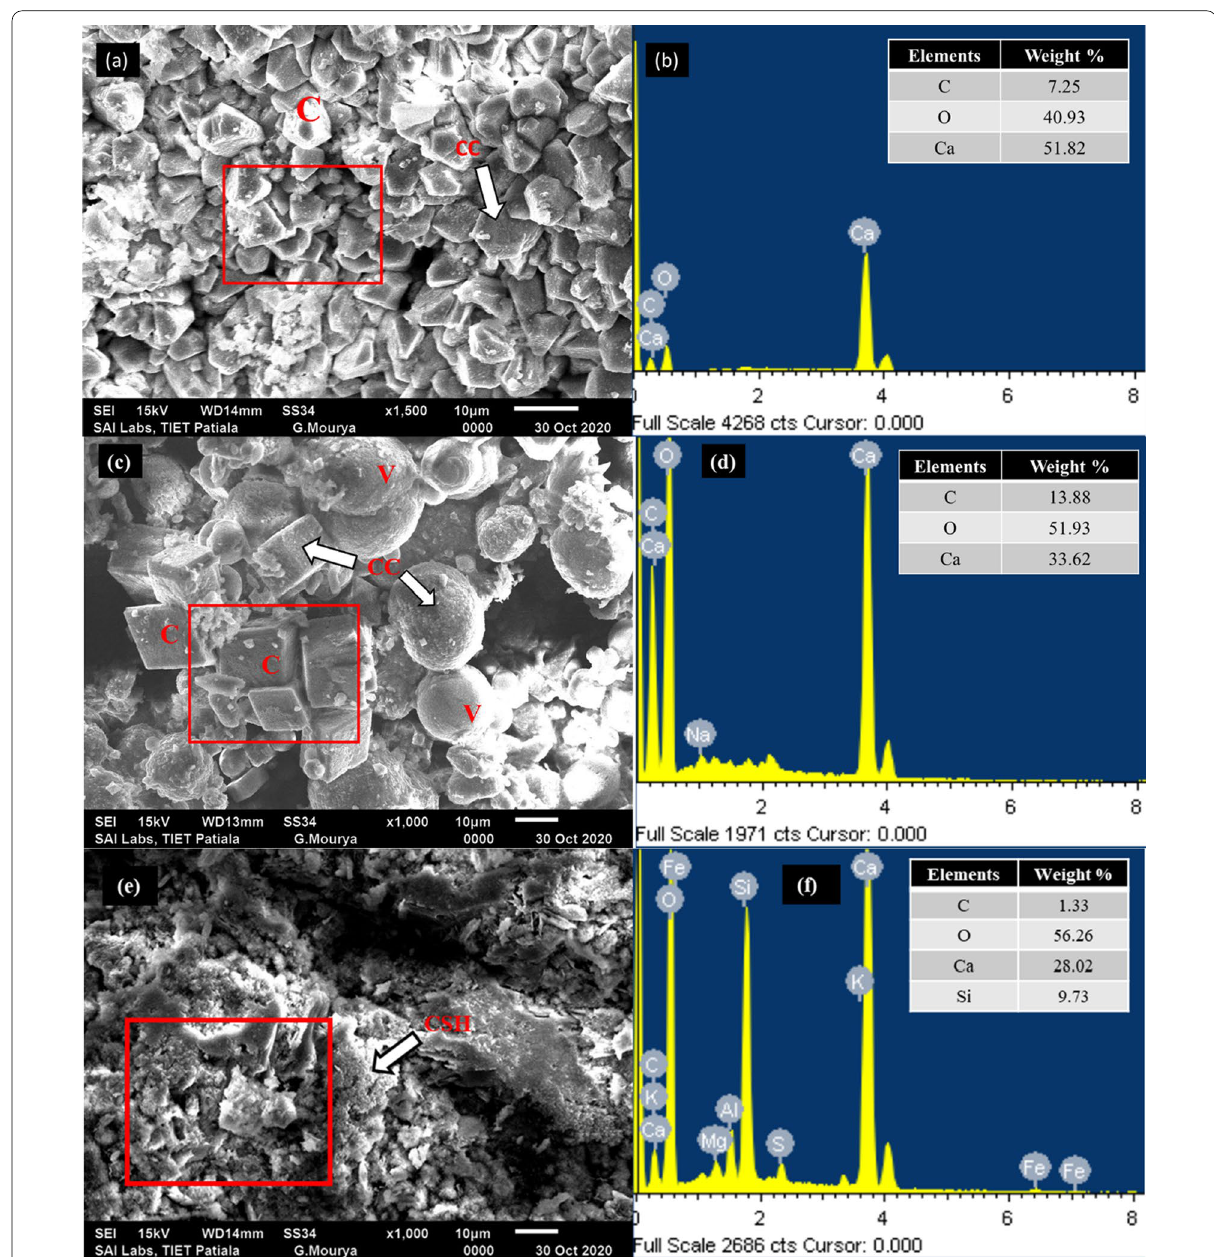
Fig. 8 SEM-EDX images represent precipitation of rhombohedral calcite (C) and spherical vaterite (V) CaCO 3 crystals (CC) in mortar specimens treated with live (LT) Synechocystis pevalekii cells ( a , b ); UV treated (UVT) S. pevalekii cells ( c , d ), and control ( e , f ). Square ‘ □ ’ sign indicates the spot